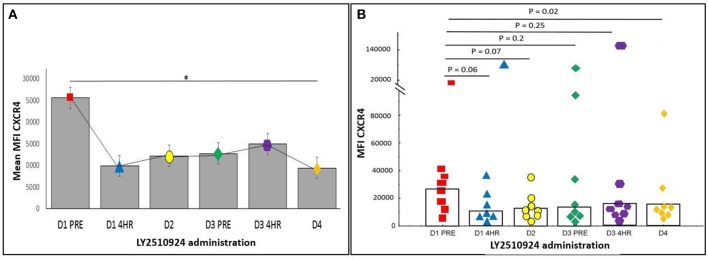
The expression of CXCR4 on peripheral blood AML blasts was determined by flow cytometry using anti-CXCR4 antibody 12G5. (A) Mean MFI with standard error over time (*p < 0.05). (B) Scatter plot showing each patient's CXCR4 MFI. Values shown are p-values comparing baseline with various post-LY2510924 time-points. Statistical comparisons were performed using the Mann-Whitney U-test. *p < 0.05.